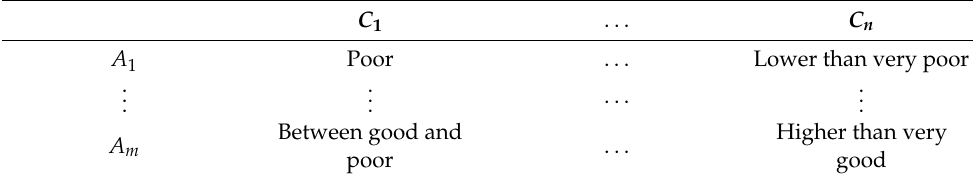
Table 1. Context-independent language evaluation matrix D 1 A 1 Poor . . . Lower than very poor . . . A m